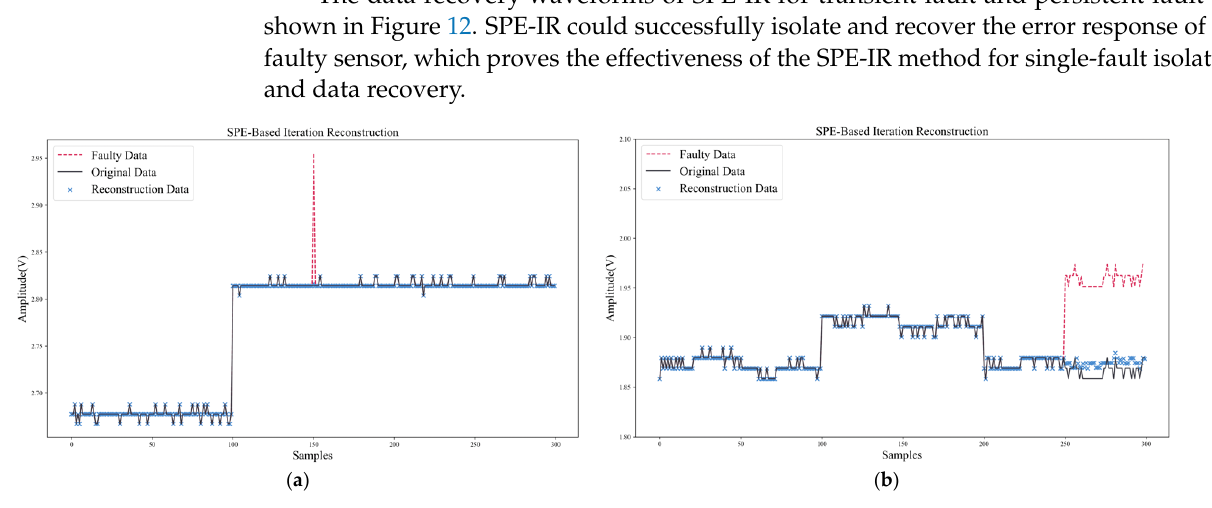
Figure 12. Data recovery of SPE-IR: ( a ) Transient fault; ( b ) Persistent fault. Table 7. Isolation Accuracy of Different Fault Isolation Methods.